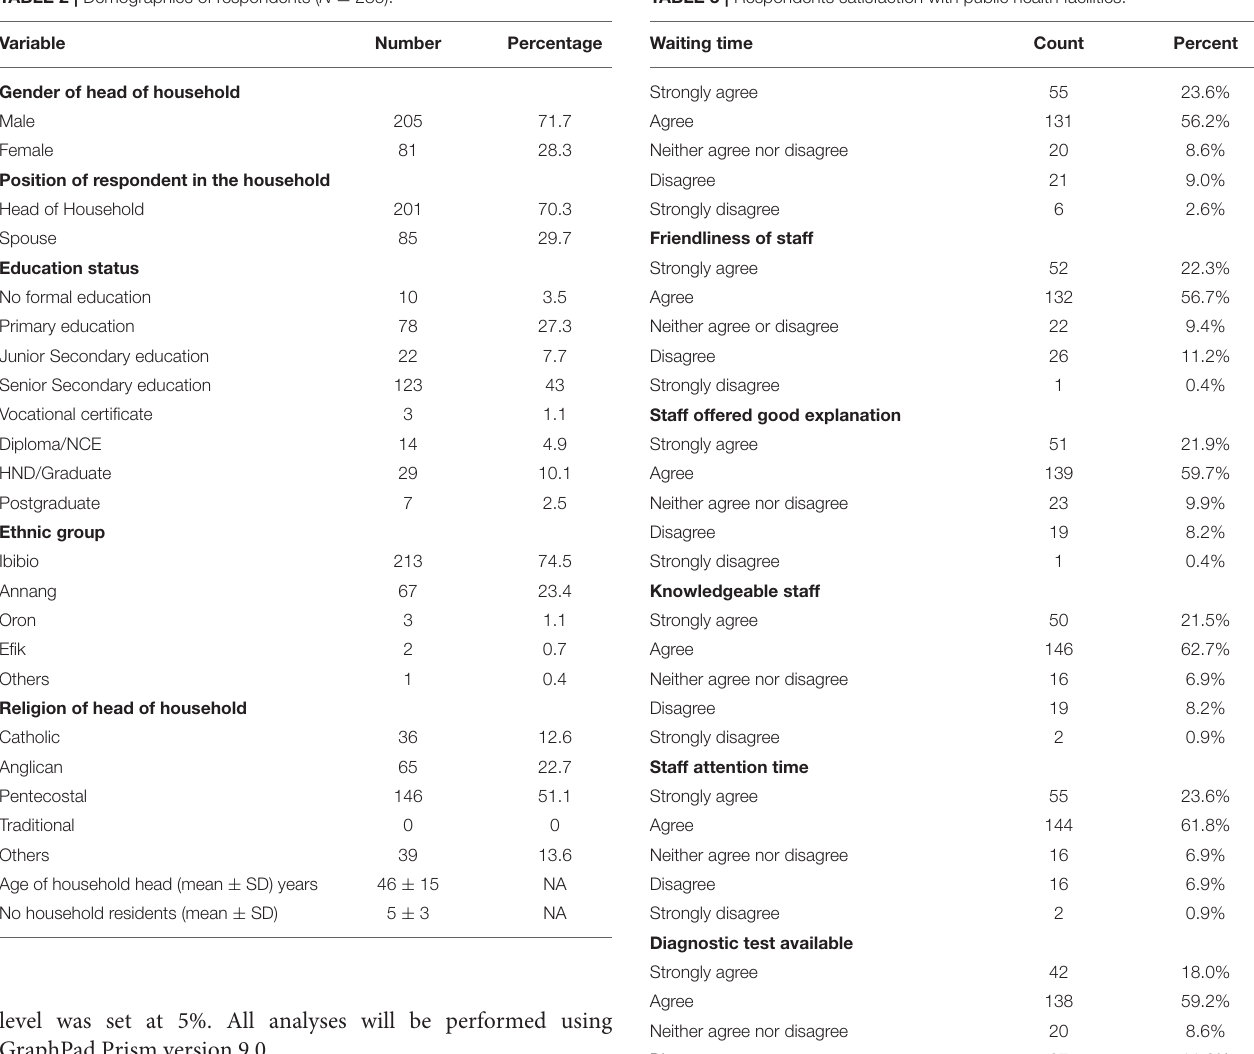
TABLE 2 | Demographics of respondents ( N = 286). TABLE 3 | Respondents satisfaction with public health